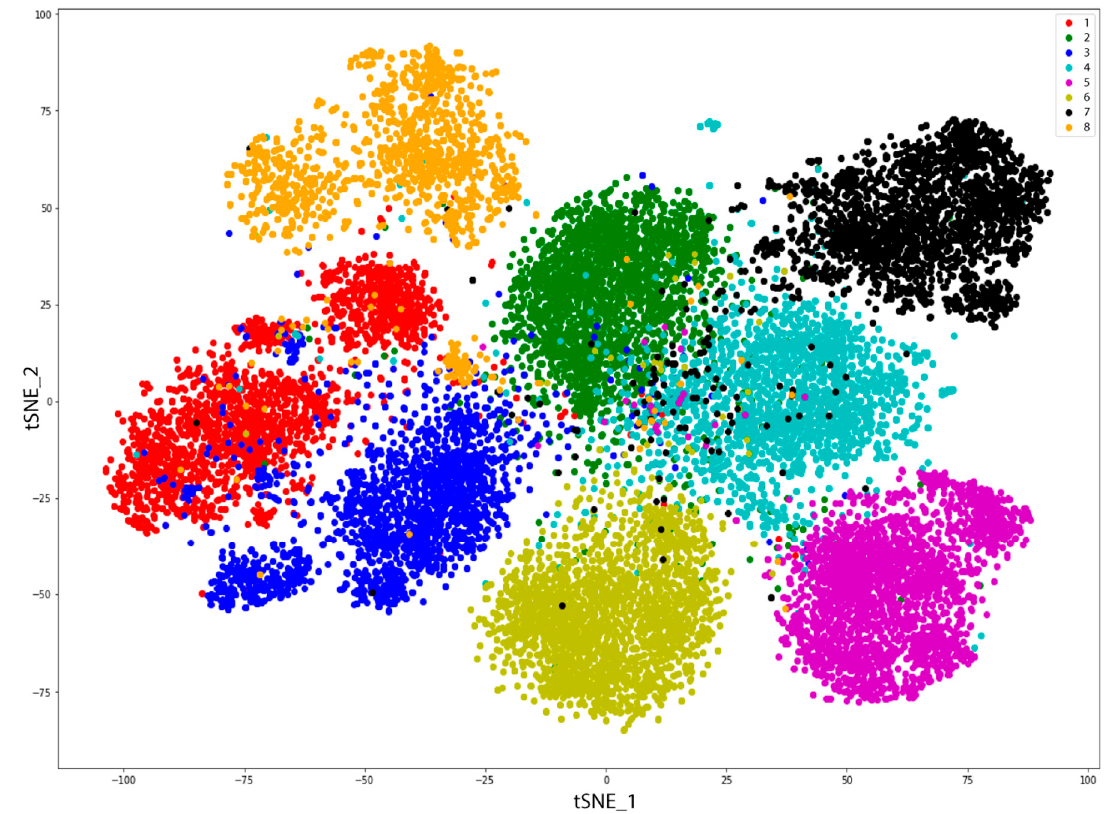
Figure 11. The t-SNE visualization shows the clustering of the Amazon dataset in 2 dimensions (tSNE_1 and tSNE_2) after reducing the dataset from 256 dimensions. Different colors represent different clusters.